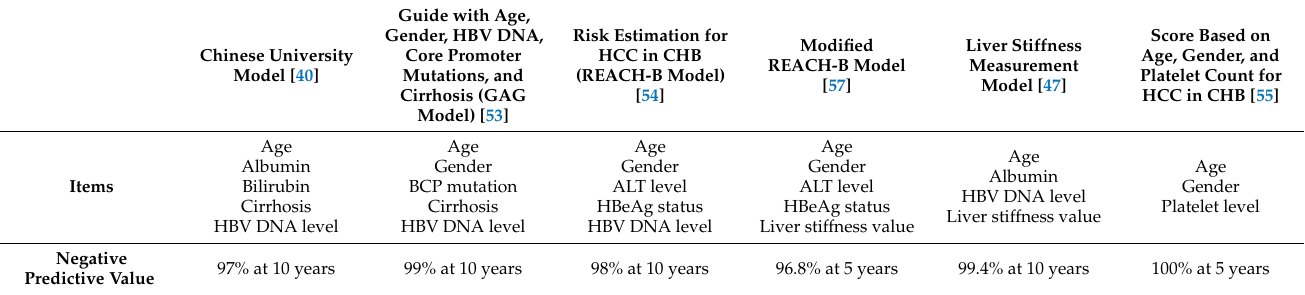
Table 1. Models that could predict HCC development in patients with